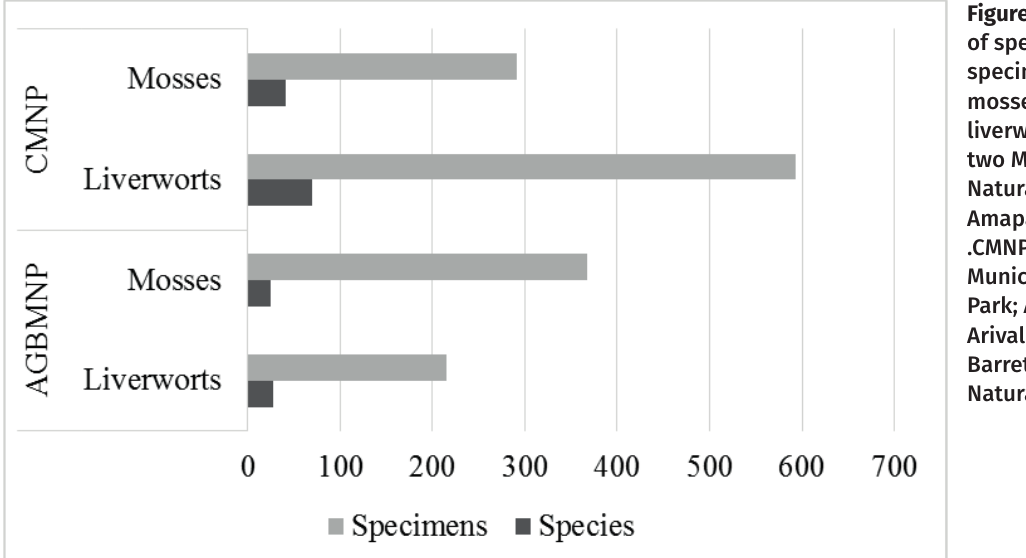
of species and specimens of mosses